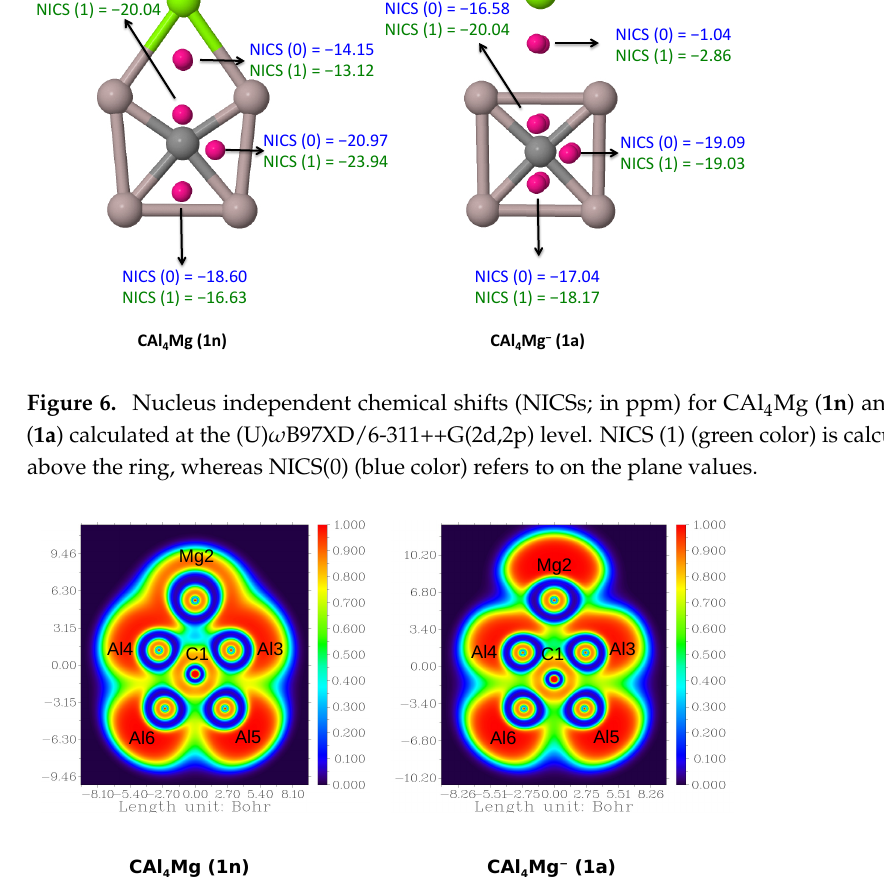
− ( 1a ) calculated at the (U) ω B97XD/6- Figure 7. Color filled map of ELF for CAl 1n ) and CAl 4 Mg ( 4 Mg 311++G(2d,2p) level. Relative geometric distances are shown in the abscissal and longitudinal coordi- nates. For clarity, the atomic label and index are added nearby the position of the corresponding atom.